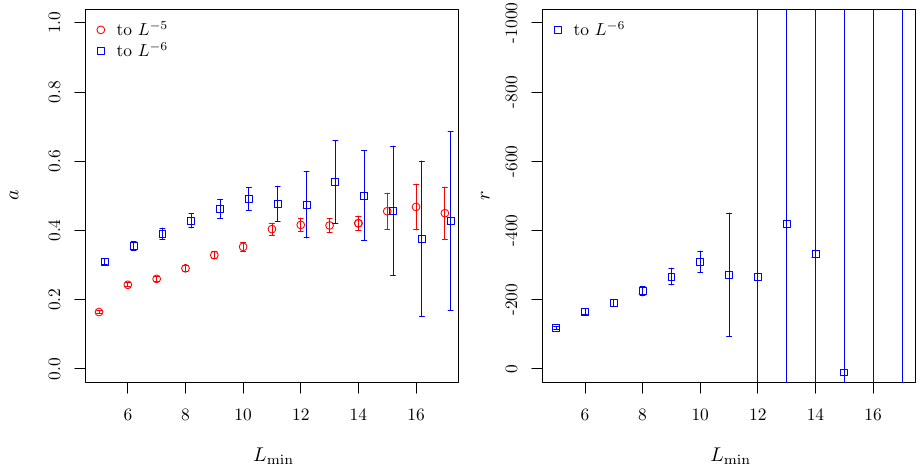
Fig. 5 The scattering length a (left) and the effective range r (right) determined by a fit of Eq. (20) to the data for (cid:7) E 2 as functions of L min with fixed L max =